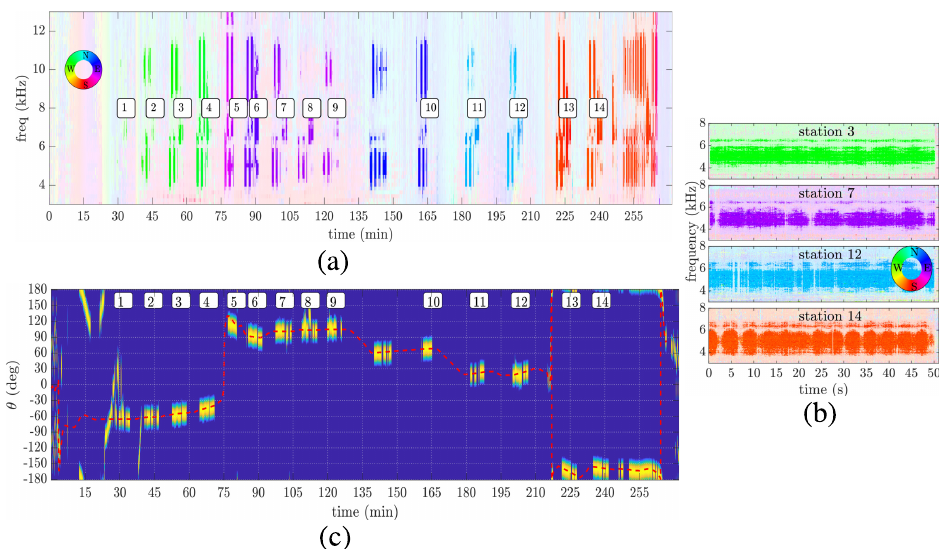
Figure 6. EMSO’21 azigram: during the overall communication test, where the number in boxes indicates transmitting stations ( a ); during transmissions at stations 3, 7, 12, and 14 (from top to bottom) ( b ); and energy detection using Bartlett estimator with estimated azimuth angle using GPS info (dashed red line) ( c ).